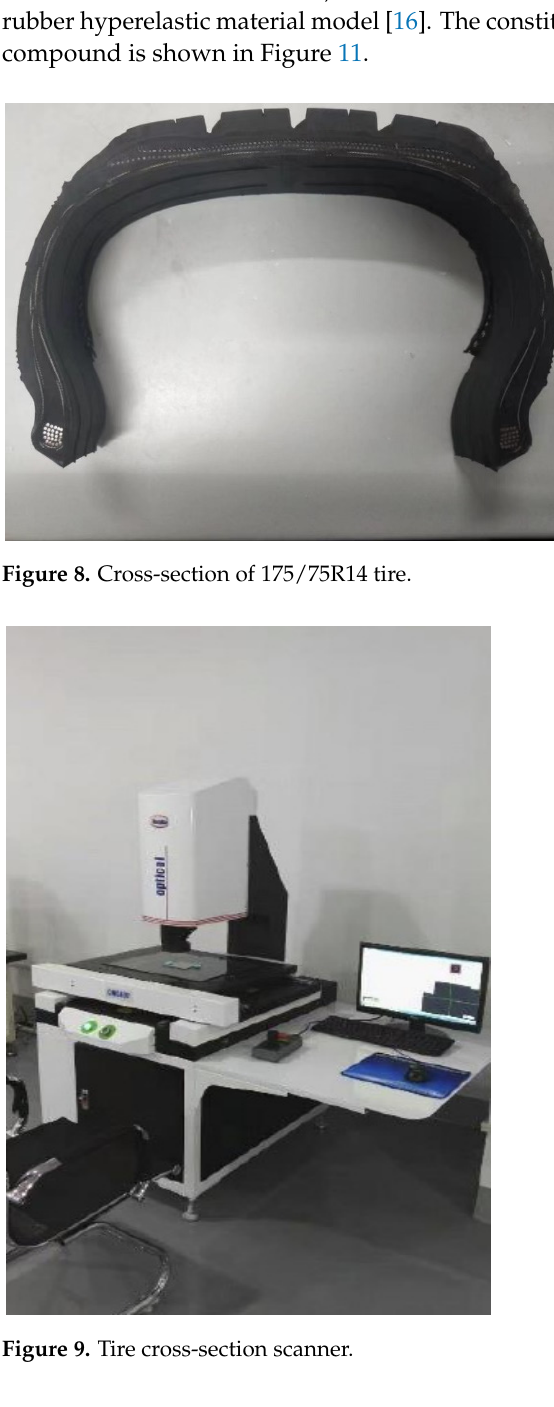
Figure 10. 2-dimensional finite element model. Tires are mainly composed of rubber and cord-rubber materials, with typical nonlin- ear stress–strain behavior. Hence, the uniaxial tension tests were performed to determine the rubber hyperelastic material model [16]. The constitutive relationship curve for each rubber compound is shown in Figure 11.